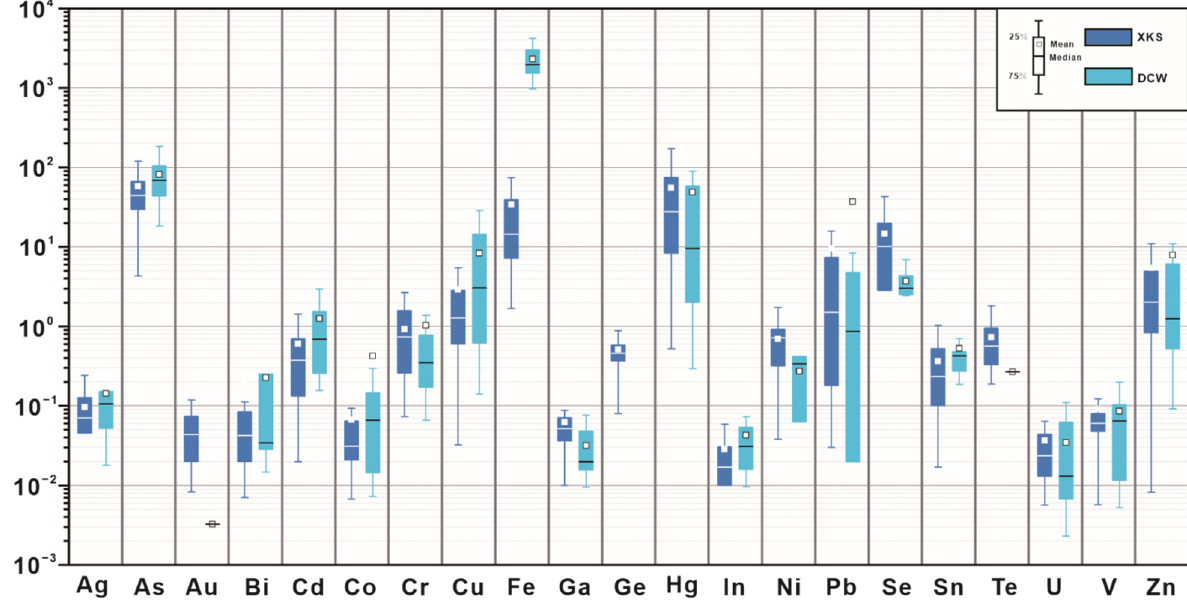
Table 1. In ‐ situ sulfur isotopic compositions of sulfide minerals in the Daocaowan Sb deposit in central Hunan province.